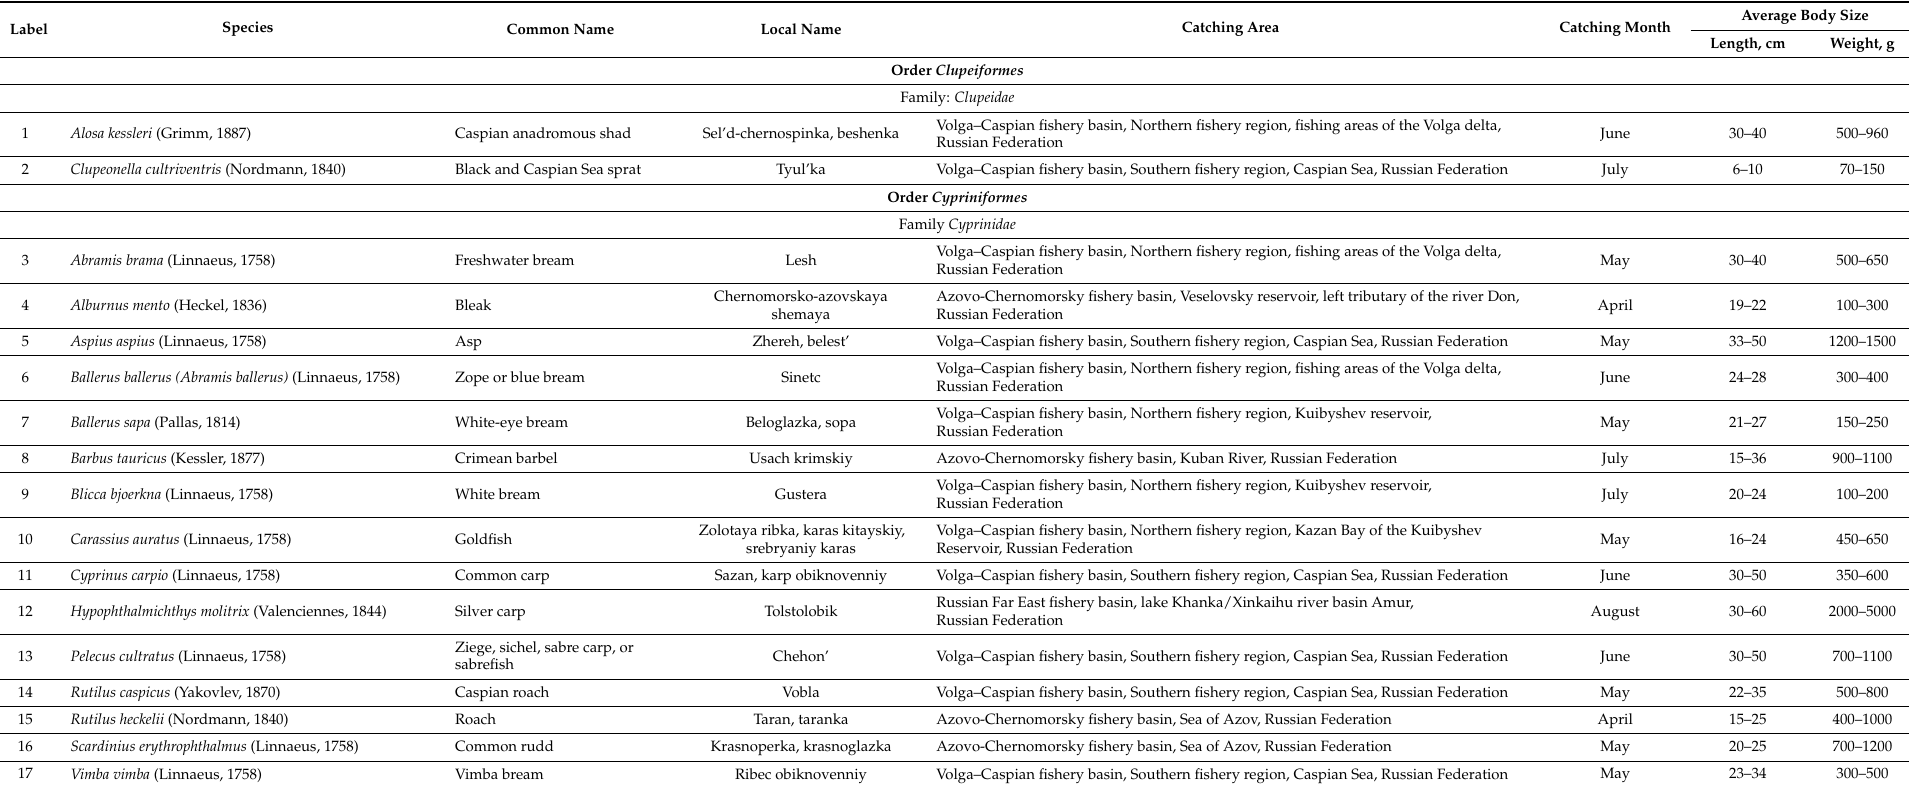
Table 1. Data on analyzed